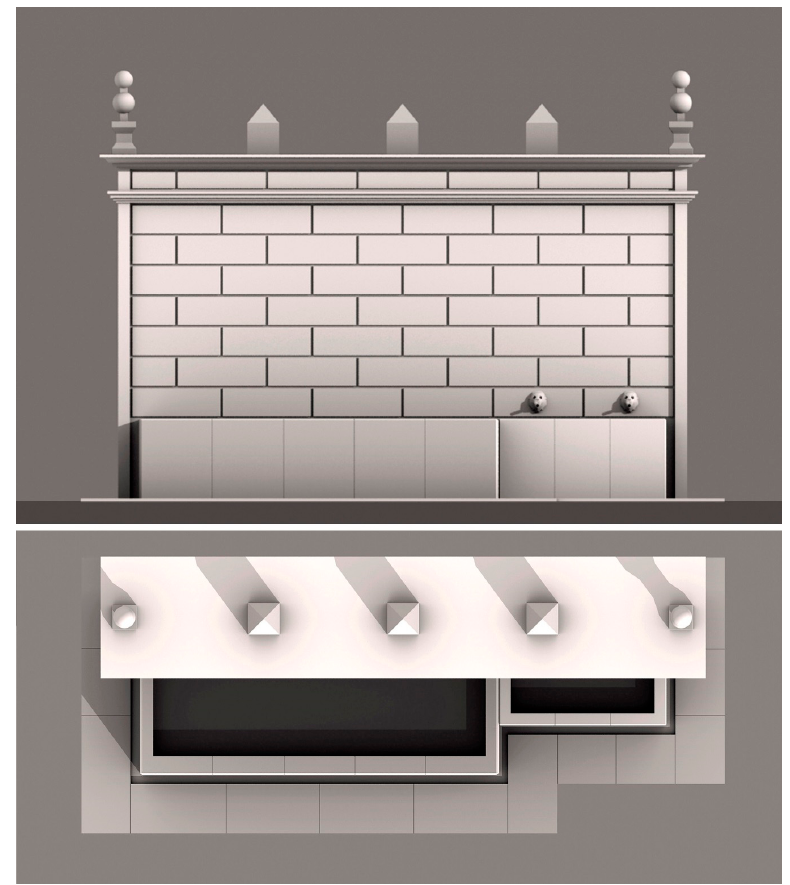
Figure 14. Plan and elevation of the virtual reconstruction of the San Pedro fountain in Lugo. The image was provided by the authors.